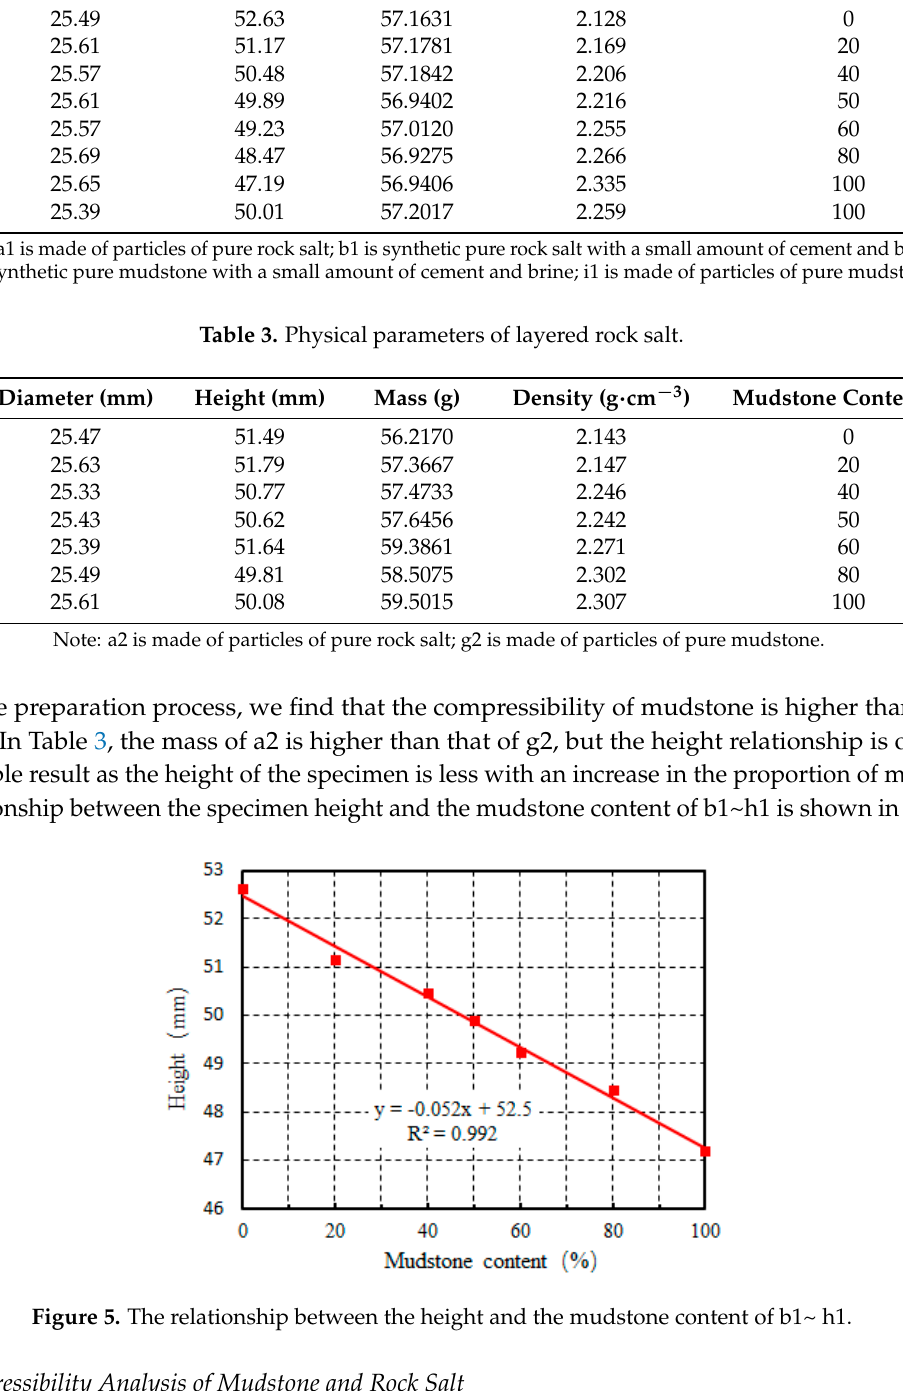
Table 3. Physical parameters of layered rock salt.